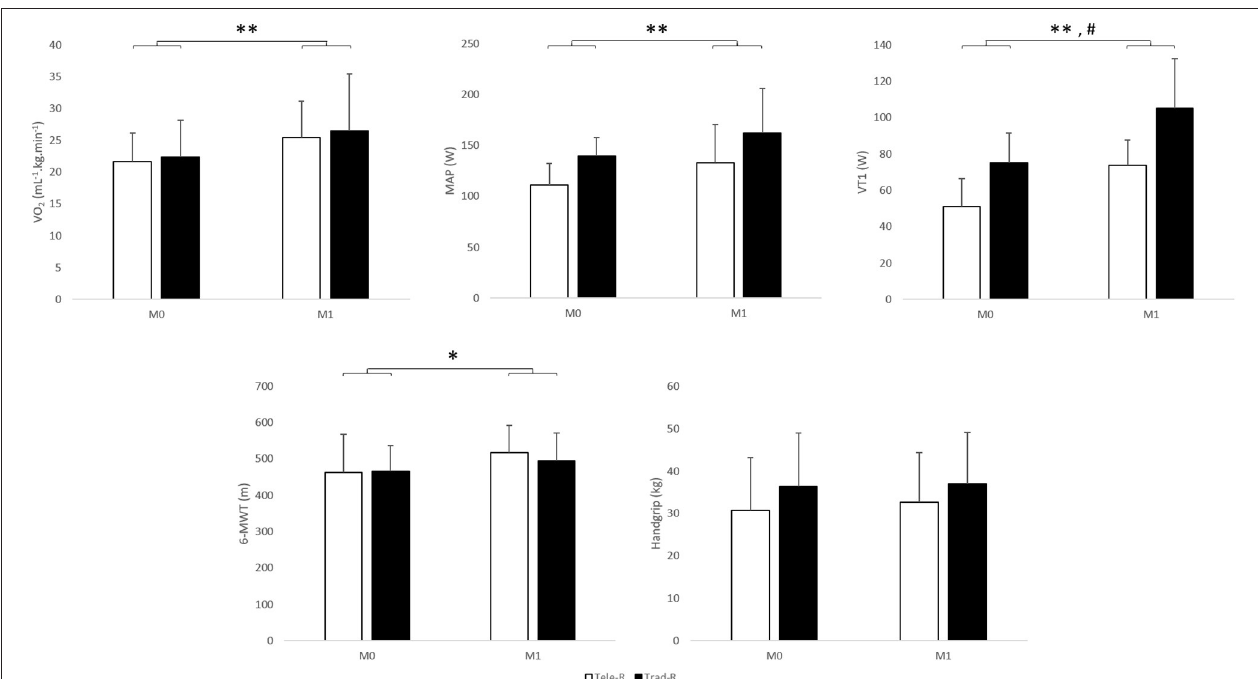
FIGURE 6 | Aerobic and anaerobic physiological variables before and after a one-month exercise program. The ANOVA showed a significant time effect for all variables and a group effect for VT1 only. No significant interaction time*group was found. Tele-R, telerehabilitation group; Trad-R, traditional rehabilitation group; VO 2 , maximal oxygen uptake; MAP, maximal aerobic power; VT1, ventilatory threshold 1; 6-MWT, 6-min walk test. *Time effect ( p < 0.05). **Time effect ( p < 0.01). # Group effect ( p <